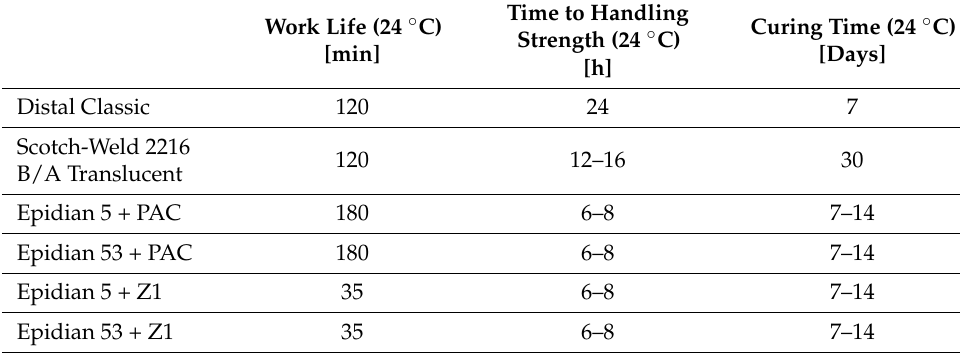
Table 1. Data for epoxy compositions.